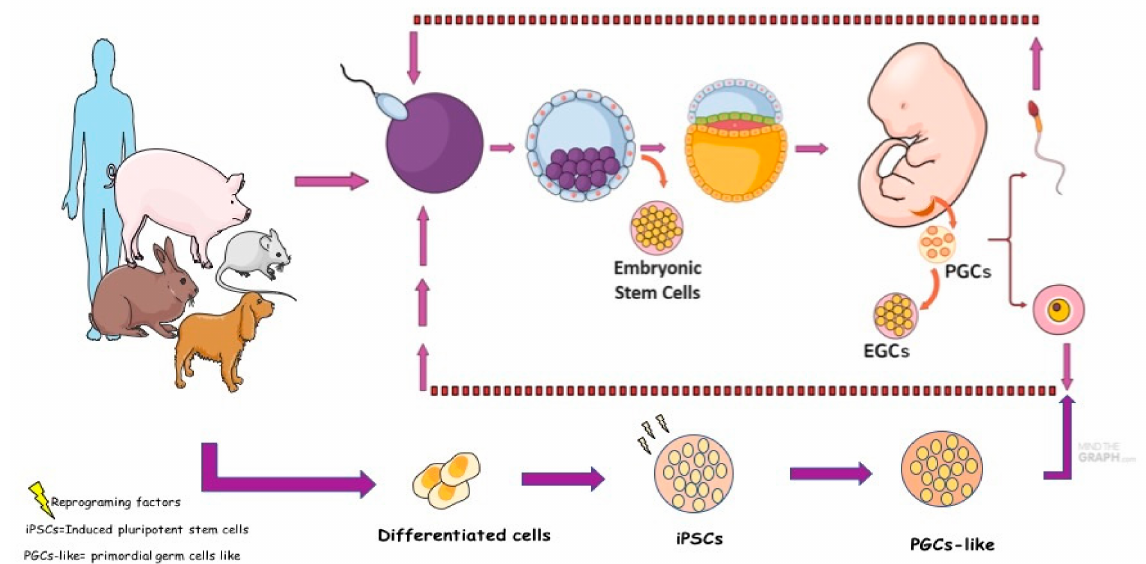
Figure 3. Schematic model of embryonic stem cell derivation (ESCs), primordial germ cells (PGCs), embryonic germ cells (EGCs), induced pluripotent stem cells (iPSCs), and primordial germ cells, such as PGC-like cells. The oocyte is penetrated by the sperm, resulting in zygote formation. During the initial mitotic division, the zygote develops into a 2-cell embryo, 4-cell embryo, initial morula, compact morula, and subsequent blastocyst—the internal blastocyst cell mass (ICM) turn, becomes the embryo in the future. The outer layer of the blastocyst contains some cells that are collectively called the trophoblast. Embryonic stem cells (ESCs) can be derived from a blastocyst ICM. During these cell divisions, the blastocyst expands into a bilaminar embryonic disc and is then transformed into a trilaminar embryonic disc through gastrulation. Gastrulation leads to the formation of the three somatic germ layers, ectoderm, mesoderm, and endoderm. Primordial germ cells (PGCs) arise from a population of pluripotent somatic cells in the proximal epiblast near the extraembryonic ectoderm. PGCs are multiplied by mitosis during the embryogenesis process and migrate to the embryo until they reach the gonadal ridge. Approximately between the period of migration and colonization of PGCs in the gonads, it is possible to derive embryonic germ cells (EGCs) in vitro. The other possibility of generating PGCs and gametes is by inducing a differentiated cell into iPSCs and transforming them using supplements into cells similar to PGCs or called primordial germ cells-like (PGCs-like). Figure adapted from Turnpenny (2005) [121] Figure created in the Mind the Graph